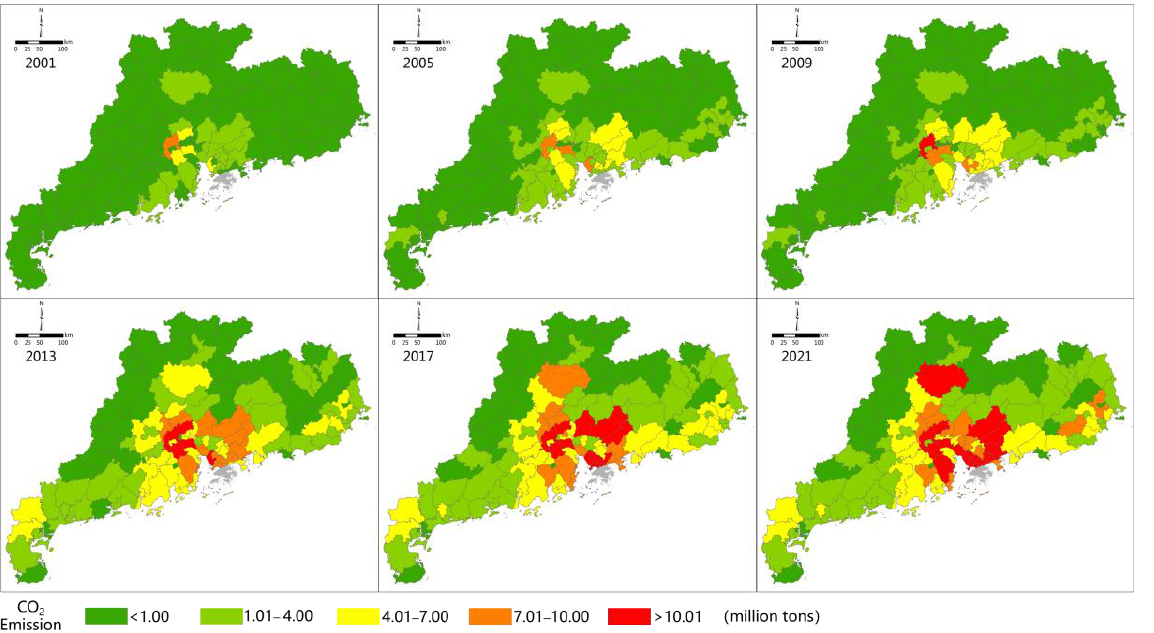
Figure 2. Time series of county-level carbon emissions from 2001 to 2021 across Guangdong Prov-